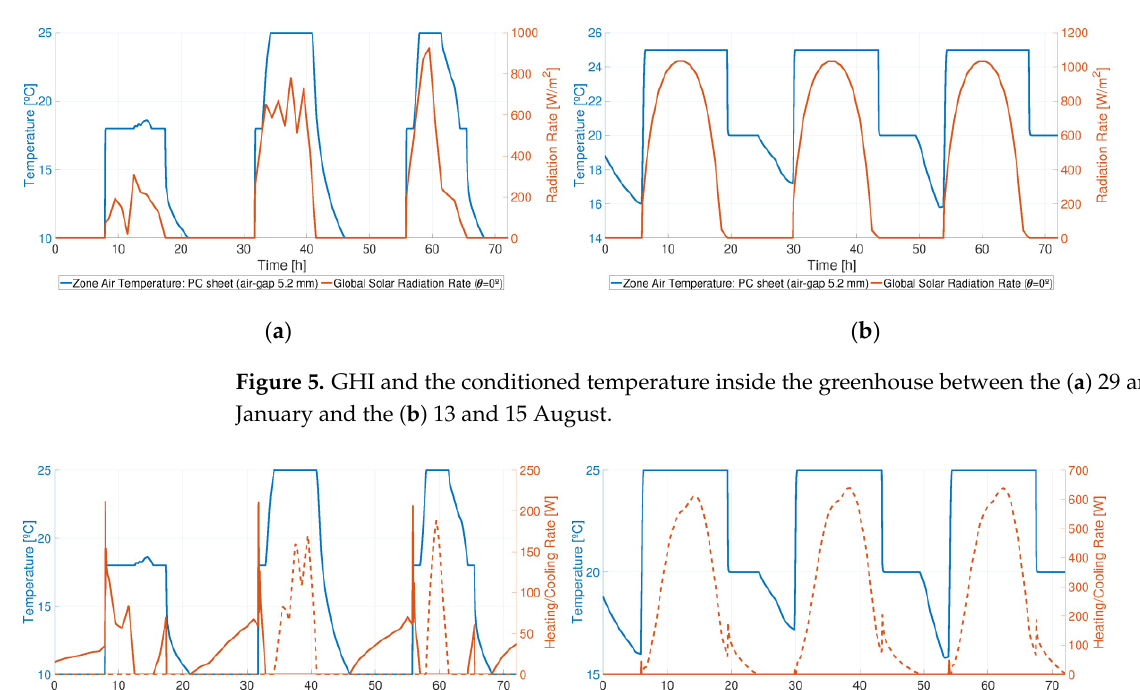
Figure 6. Ideal heating and cooling rates and the conditioned temperature inside the greenhouse between the ( a ) 29 and 31 January and the ( b ) 13 and 15 August.